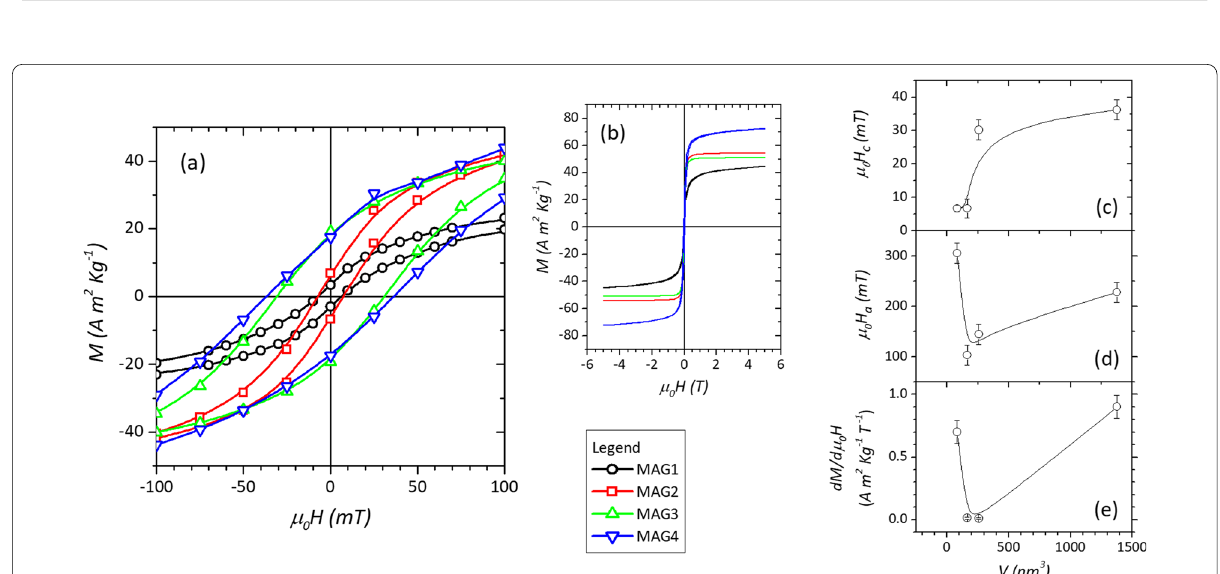
Fig. 3 a A magnification at low field of the M versus H curves measured at 5 K for all samples with b the full range of measurement. The size dependence of coercive field ( µ 0 H C ), anisotropy field (µ 0 H a ), and the high-field susceptibility (dM/dµ 0 H) measured at 5 T are reported in panels c , d , and e , respectively, with lines used as a guide to the